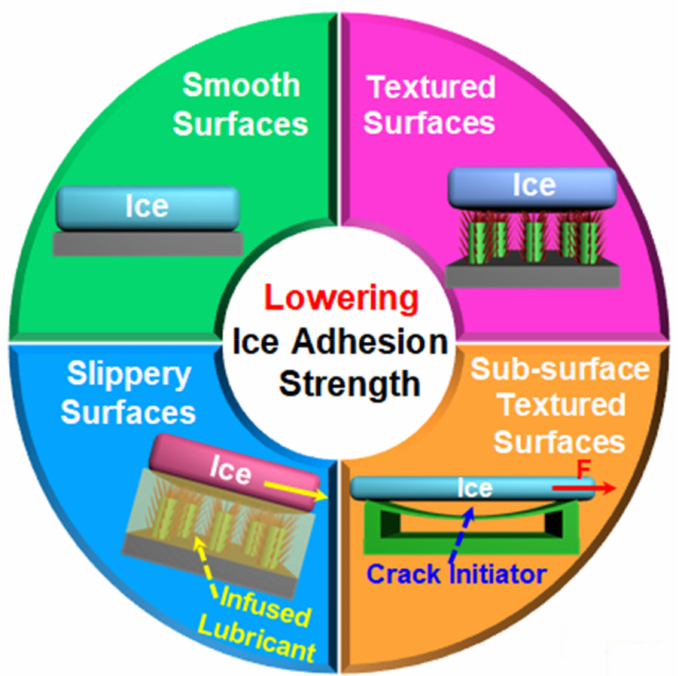
Figure 2. Strategies towards designing icephobic surfaces by lowering ice adhesion strength can be roughly divided into four types via surface properties: smooth surfaces, textured surface (i.e., hierarchical hydrophobic surfaces or SHSs), slippery surfaces, and sub-surface textured